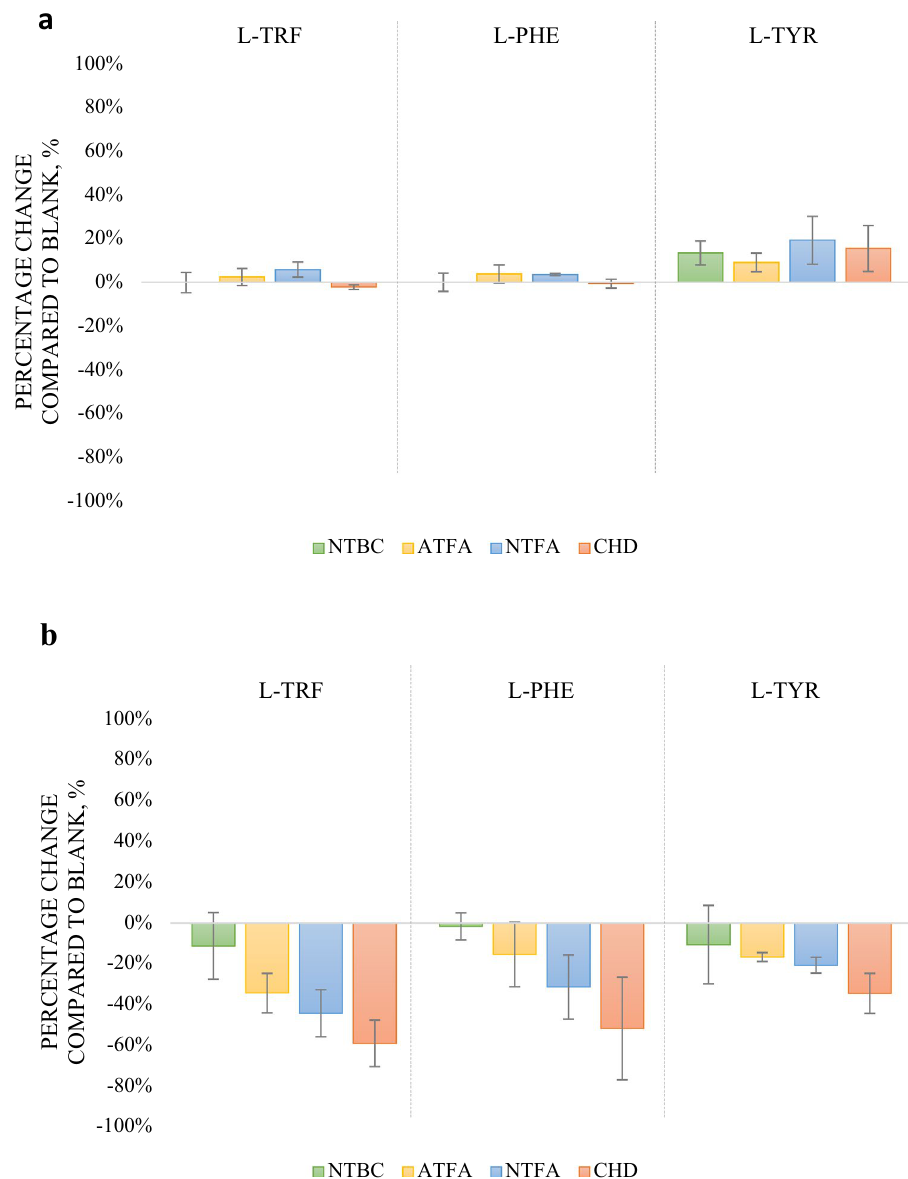
Figure 4. Percentage changes in the concentrations of metabolites of l-TYR, l-TRF, and l-PHE in yeast exposed to NTBC, NTFA, ATFA, and CHD after 30 min ( a ) and after 120 min of incubation ( b ). Blank was taken as 0%. Data are expressed as mean (n = 6); error bars represent